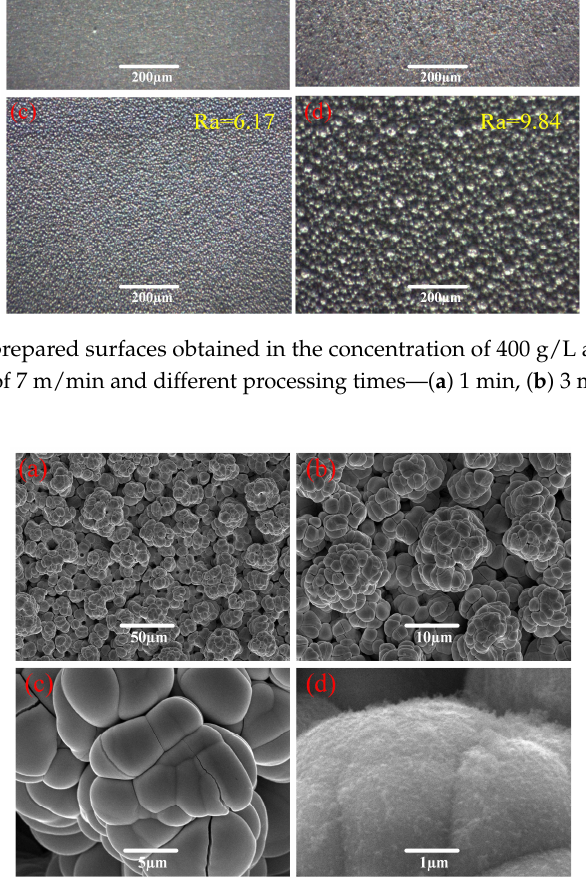
Figure 1. Photos of prepared surfaces obtained in the concentration of 400 g/L at the voltage of 25 V, the relative velocity of 7 m/min and different processing times—( a ) 1 min, ( b ) 3 min, ( c ) 5 min, and ( d ) 7 min.